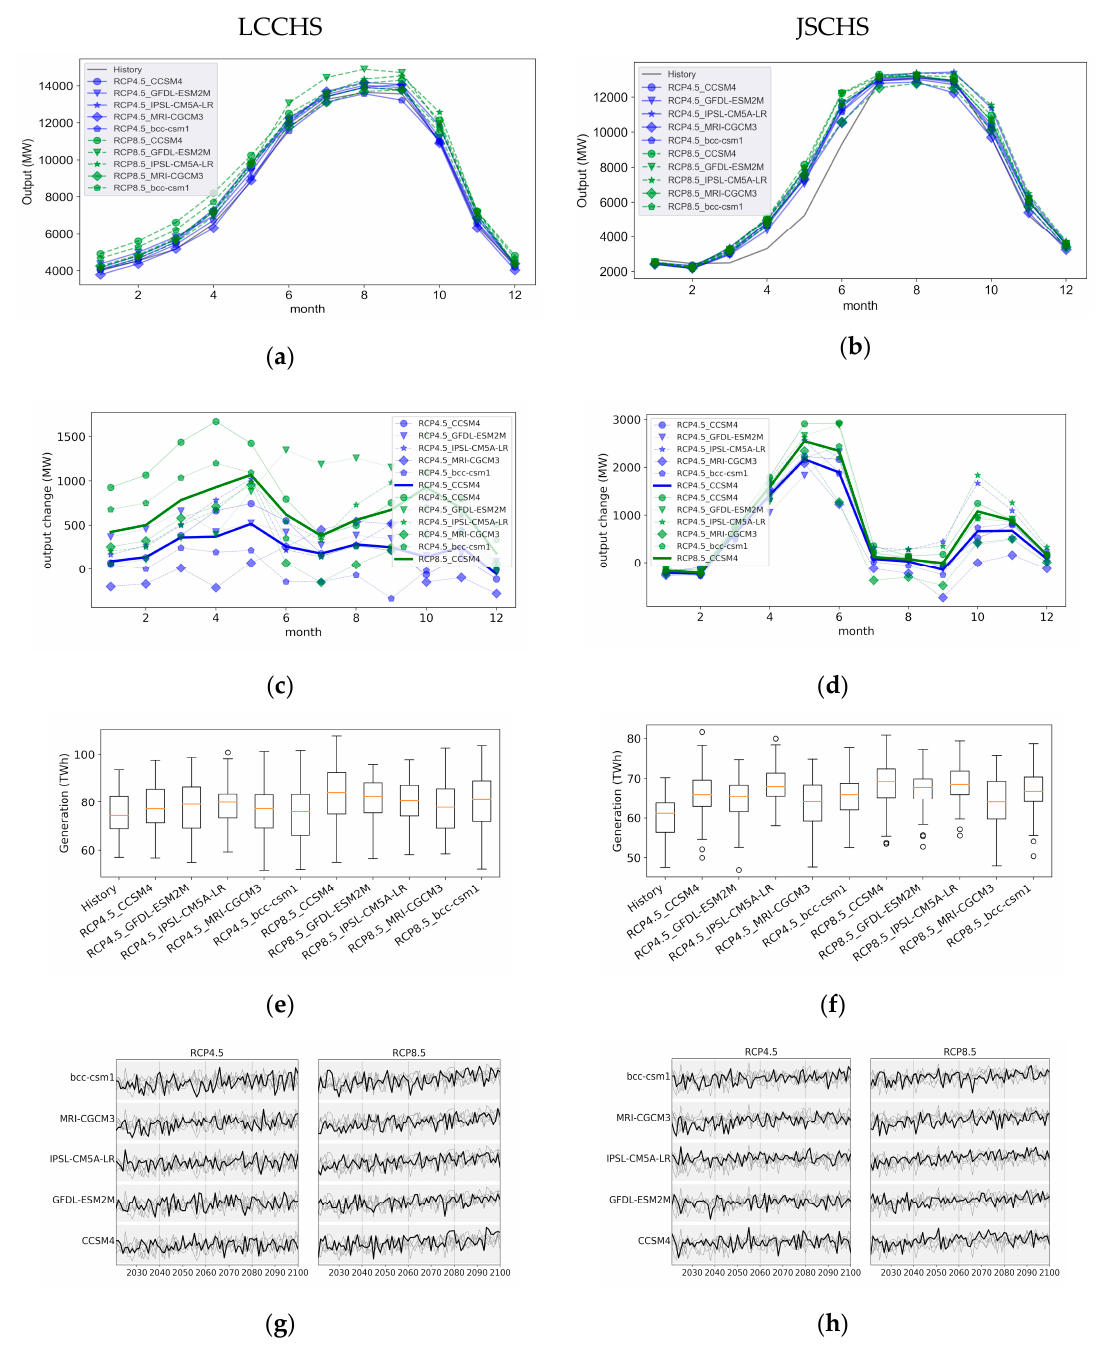
Figure 8. The generation and output of LCCHS and JSCHS under climate change projections. ( a , b ) Monthly average output; ( c , d ) change in monthly average output compare to historical model simulation; ( e , f ) yearly generation distribution; ( g , h ) yearly generation. In each subfigure, the thick line represents the generation of the corresponding GCM, and the thin lines represent the generation of other GCMs.